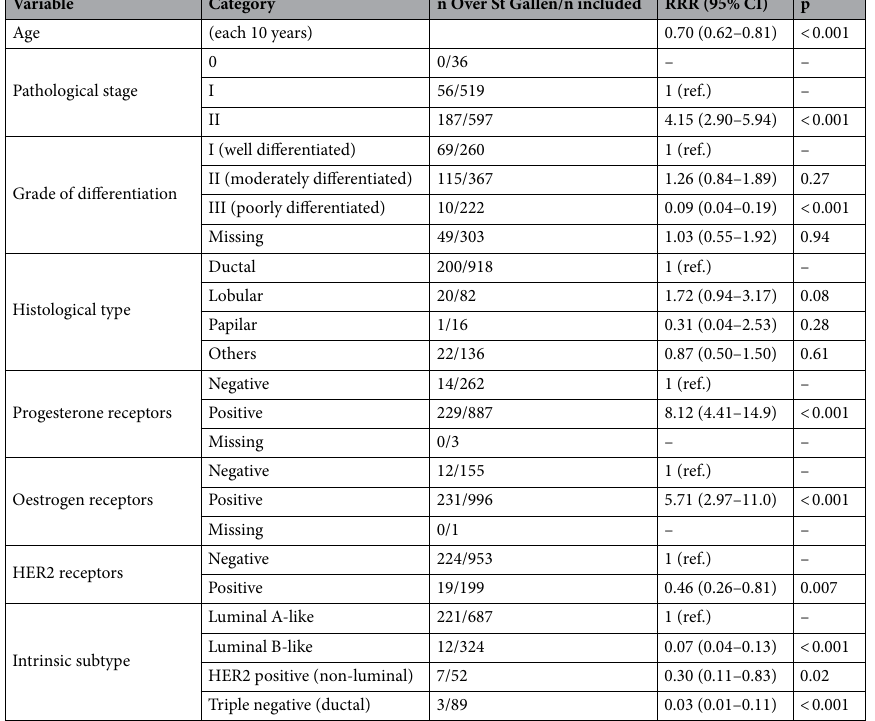
Table 3. Tumour characteristics associated with “Over St Gallen” treatment. Relative risk ratios (RRR) are adjusted for age at diagnosis and hospital of